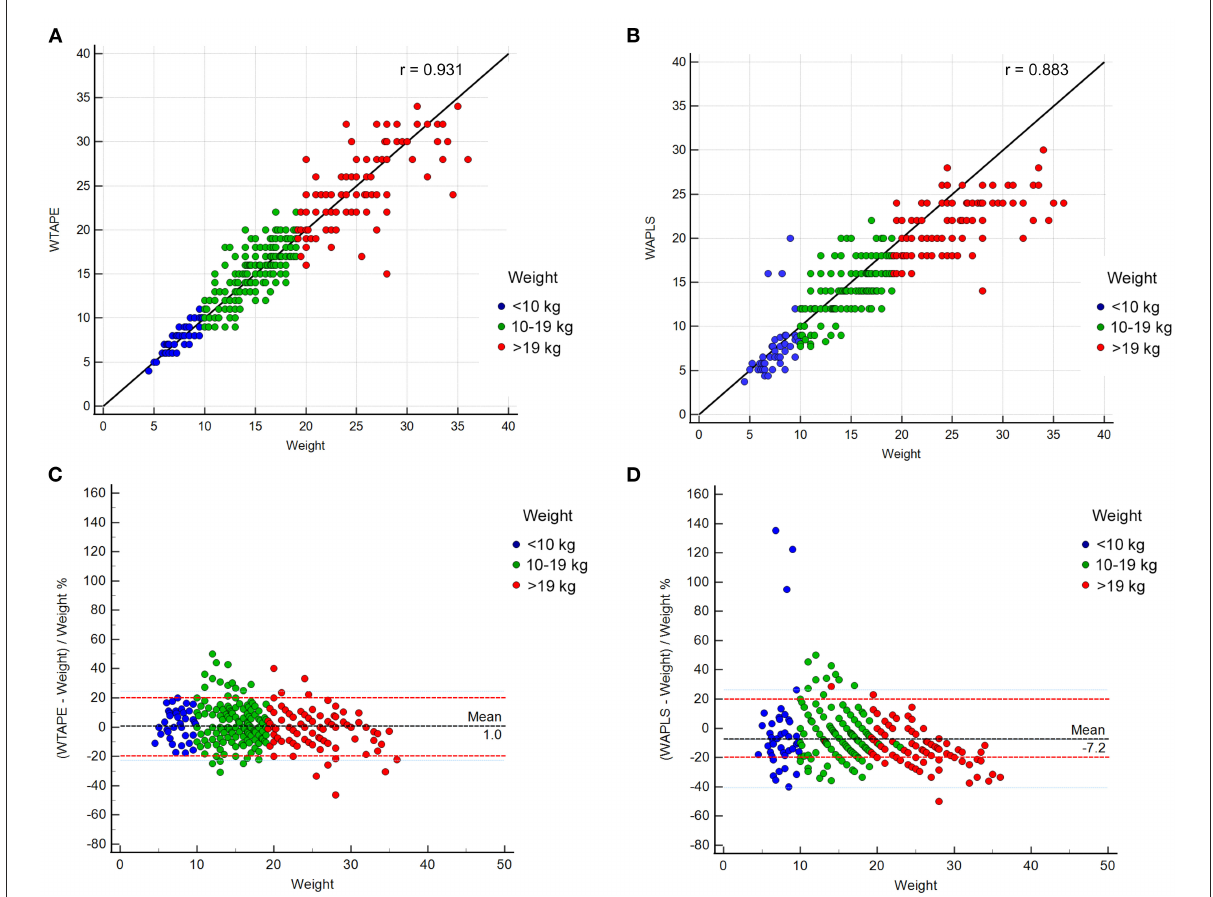
FIGURE1 (A) Correlation analysis between the Broselow tape estimated weight and actual weight; (B) Correlation analysis between the advanced pediatric life support (APLS) method-calculated weight and actual weight. (C) Percentage error between the Broselow tape estimated weight and actual weight; (D) Percentage error between the formula estimated weight and the actual weight. WTAPE, Broselow tape estimated weight; WAPLS, advanced pediatric life support method-calculated weight.